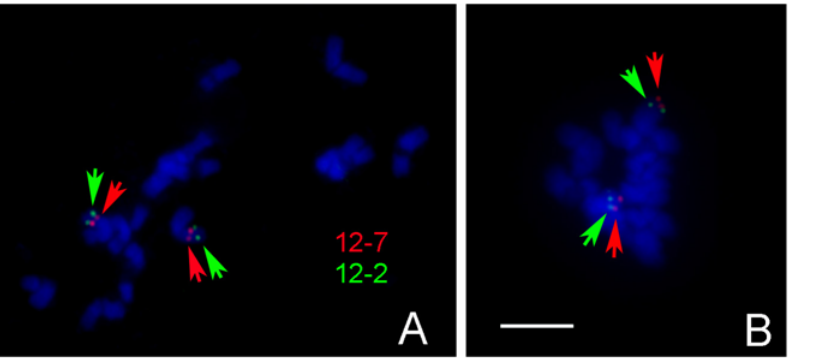
Figure 4. An inversion detected by FISH on cucumber chromosome 5 between GY 14 and PI183967. (A) Locations of the fosmid 12-7 (SSR20648, red) and 12-2 (SSR13340, green) on chromosome 5 of GY14. Red signals are located closer to the telomere than green signals. (B) Locations of the fosmid clones on chromosome 5 of PI 183967. Note that green signals are closer to the telomere. Bars=3 m m.